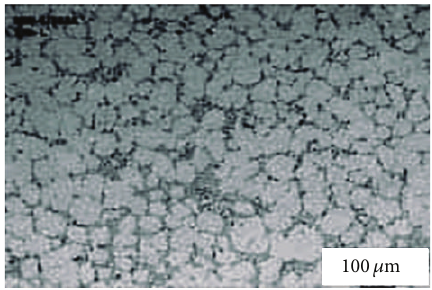
Figure 17: Microstructure of 356 alloy obtained by the New MIT process using air cooling as the stirring method [42].